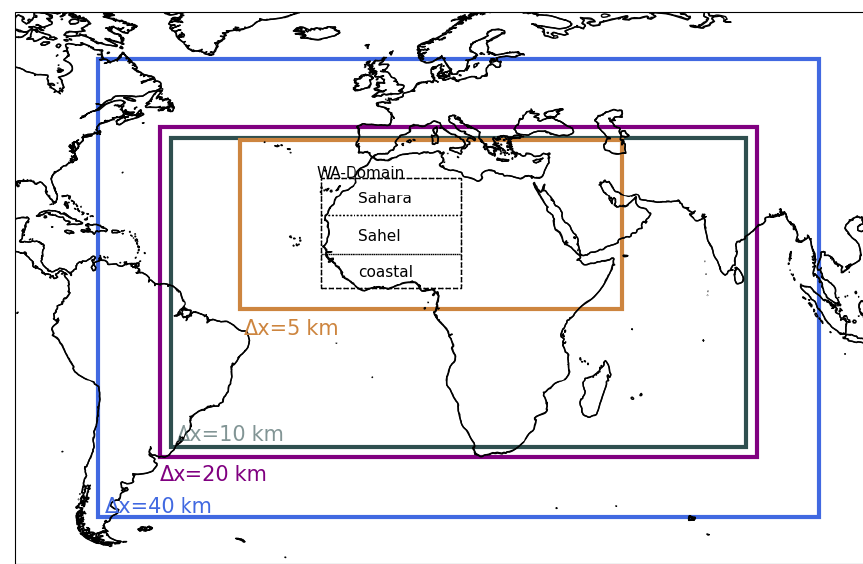
Figure 1. Solid colored domains outline the nesting domains of the simulations for the various grid spacings (as indicated). The dashed black domain labeled “WA domain” (West Africa) displays the main analysis domain. The WA domain spans the area from 5–31 ◦ N and from 18 ◦ E–15 ◦ W. The three dotted black domains within the WA domain are used to distinguish the coastal African region (“coastal”), the Sahel region (“Sahel”), and the Saharan region (“Sahara”) that are indicated in the longitudinal mean plots. The coastal region spans from 5–13 ◦ N and from 18 ◦ E–15 ◦ W. The Sahel region spans from 13–22 ◦ N and from 18 ◦ E–15 ◦ W and the Sahara region from 22–31 ◦ N and from 18 ◦ E–15 ◦